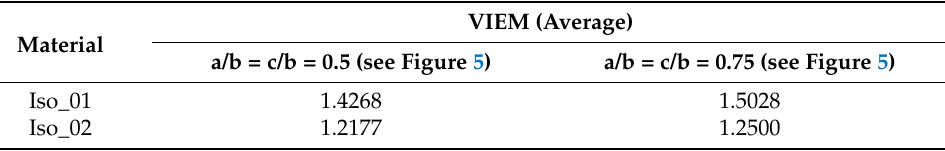
Table 10. Normalized tensile stress component ( σ xx / σ o xx ) within the isotropic prolate spheroidal inclusion due to uniform remote tensile loading ( σ o xx